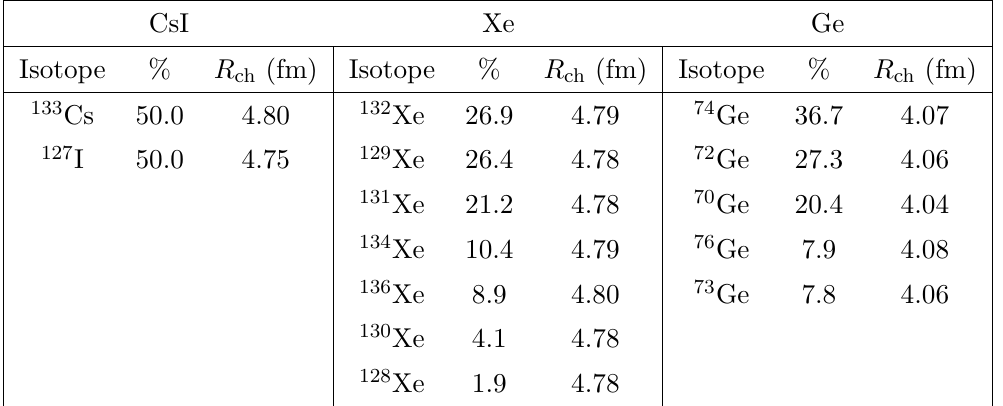
Table 2 . Charge radius ( R ch ) and abundances (%) used for the di(cid:11)erent isotopes considered in this work. While for the CsI detectors we assume a 50% number abundance of Cs and 50% of I, for Xe and Ge we use their natural isotope abundances from ref. [82]. The values for the charge radii, taken from ref. [43], are measured to a few per mil precision, and therefore we ignore their error bars in our